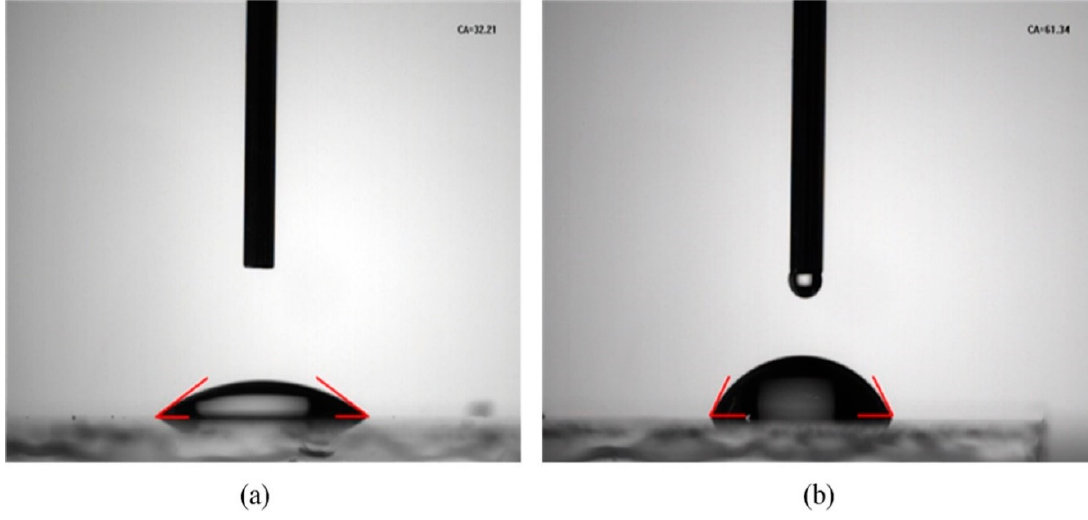
Figure 6. Contact angle (CA) measurements of ( a ) ZnO (aqueous) and ( b ) ZnO (sol-gel).